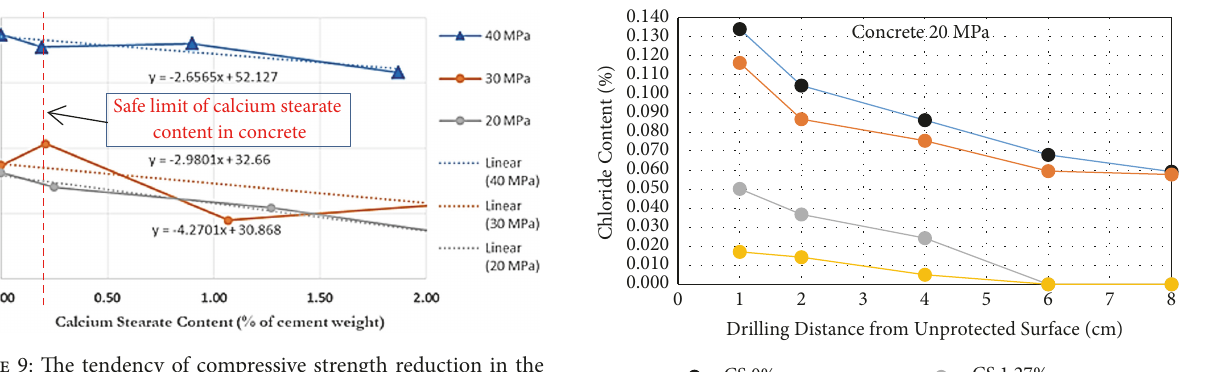
Figure 9: The tendency of compressive strength reduction in the concrete.